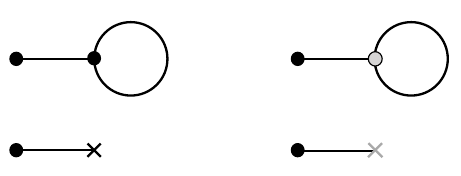
Figure 1 . (Top) One loop contributions to the one-point function in a λφ 3 theory. (Bottom) The corresponding Y counterterm